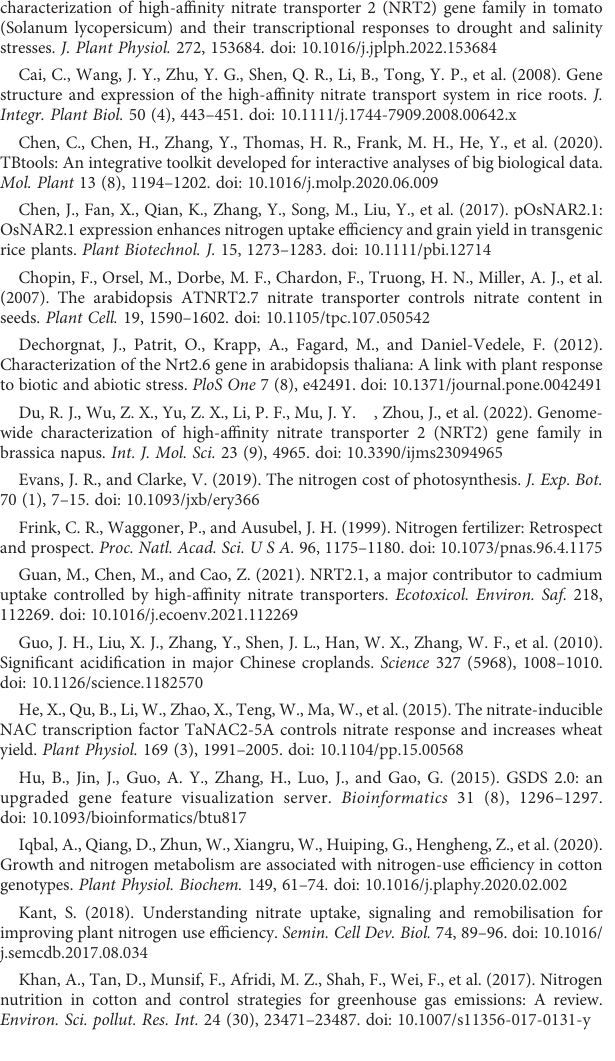
SUPPLEMENTARY FIGURE 1 The expression of GhNRT2.A1-A7 in different organs compared by RNA-seq data and RT-PCR data (For easy comparison, all root data were set to 1). SUPPLEMENTARY FIGURE 2 The expression of GhNRT2.A1-A7 in different treatments compared by RNA- seq data and RT-PCR data (For easy comparison, all CD data were set to